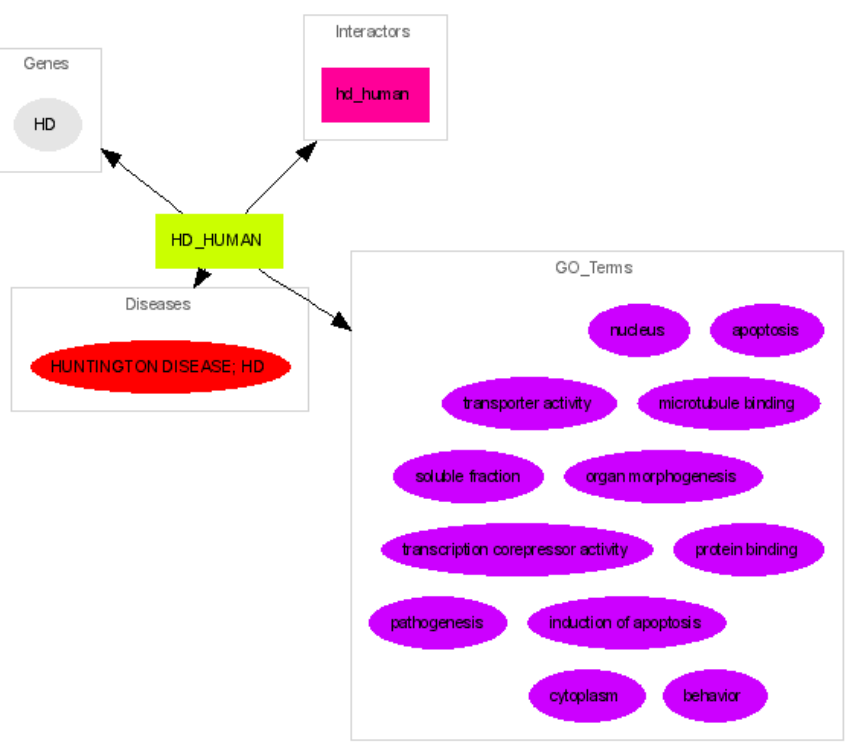
Figure 7: Huntington’s disease protein (HD_Human) and its relation with other domains as shown in